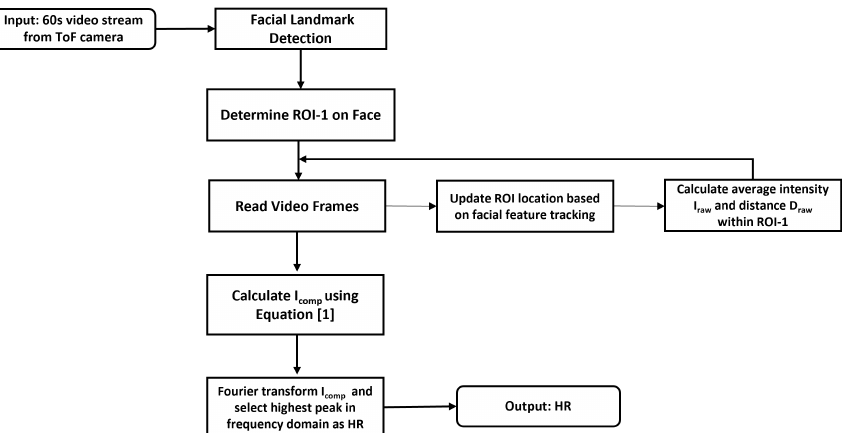
Figure 6. HR extraction process from the 3D video streams of a ToF